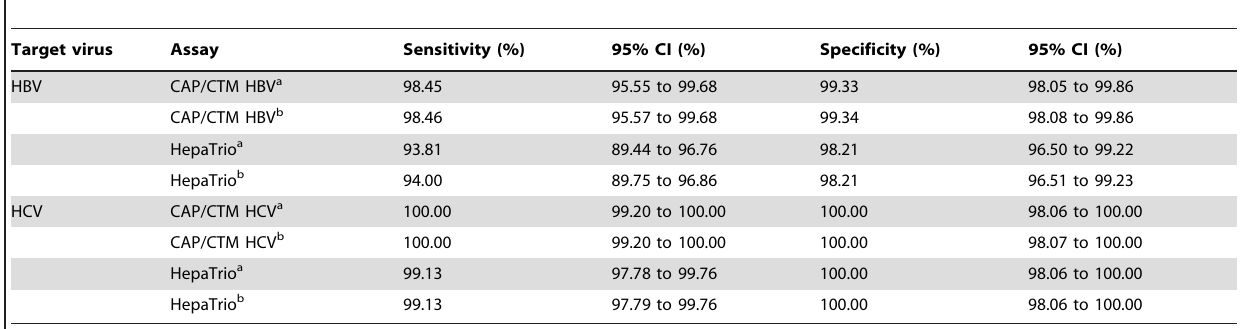
Table 3. Sensitivities and specificities of the HepaTrio test and the CAP/CTM assays for detecting HBV and HCV infections.